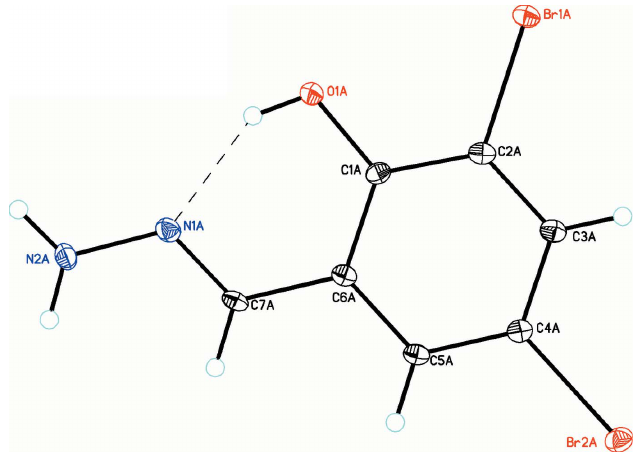
Figure 1 The molecular structure of the title compound, showing 50% probability displacement ellipsoids. The intramolecular O—H (cid:2)(cid:2)(cid:2) N hydrogen bond forming an S (6) ring motif is shown as a dashed line.